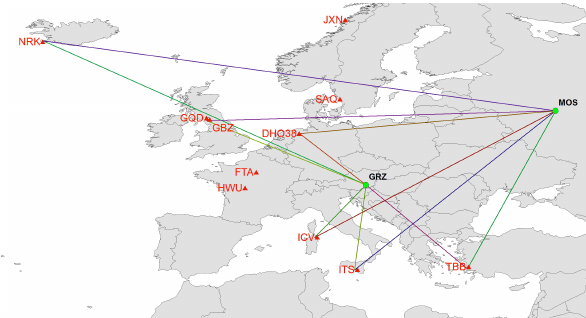
Figure 2. The same as in Fig. 1 but for the European network. The position of the receivers in Moscow (MOS) and Graz (GRZ) and different transmitters in Europe is shown on the map. Sig- nals from six transmitters are analysed: NRK (37.5kHz), ICV (20.27kHz), ITS (45.9kHz), TBB (26.7kHz), DHO (23.4kHz) and GBZ